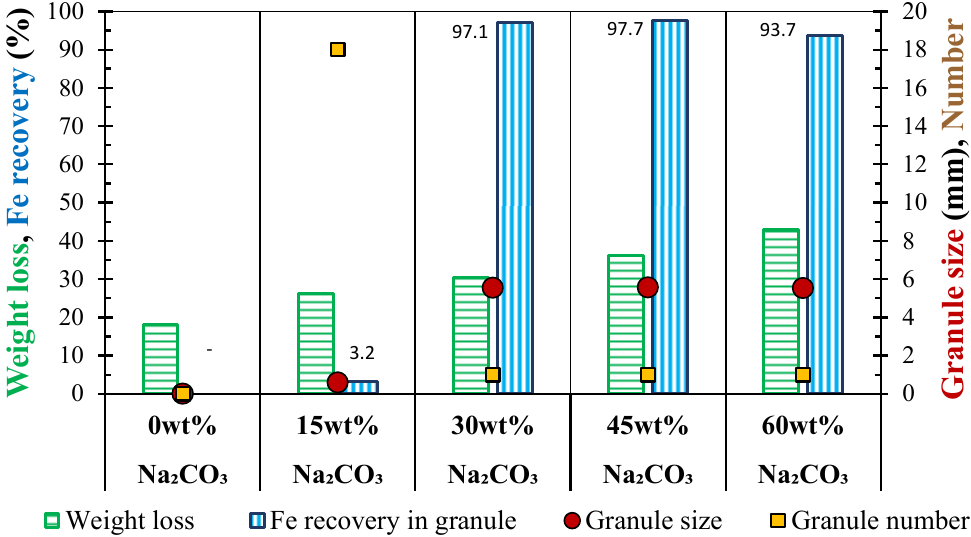
Figure 9. Effect of Na 2 CO 3 addition on weight loss, iron recovery in granule, granule diameter, and number of granules from the carbothermic reduction of the ilmenite concentrate at different Na 2 CO 3 additions, the initial temperature of 1300 ◦ C, final temperatures of 1500 ◦ C, and heating rate of 6.6 ◦ C/min (pattern G).